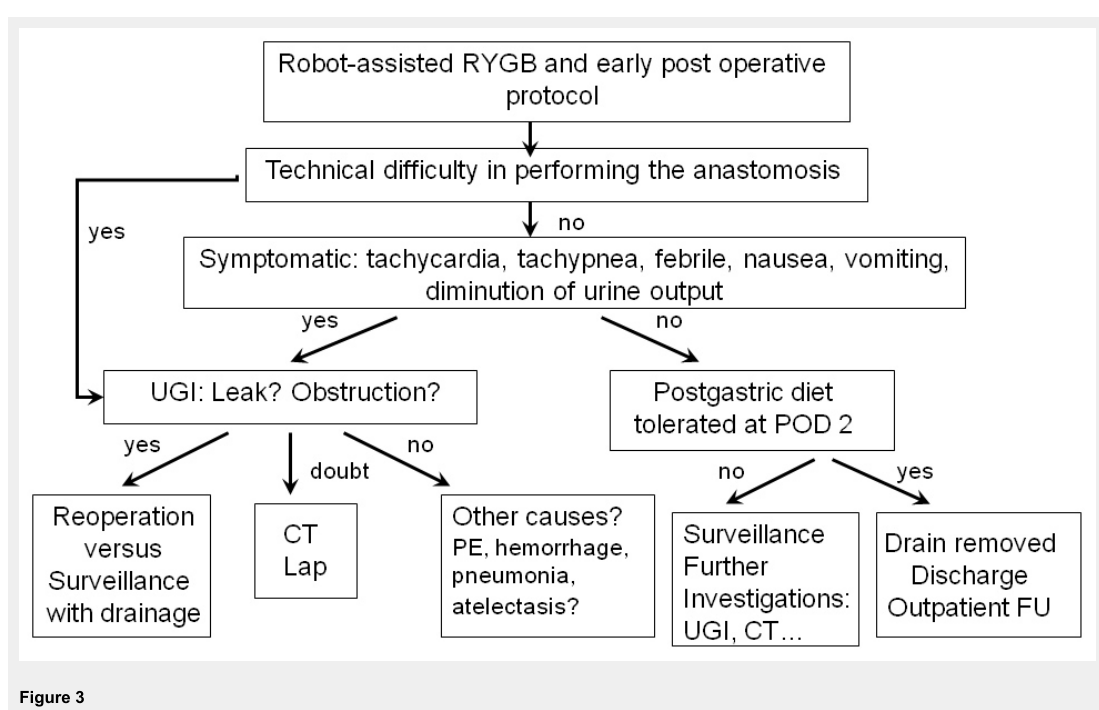
Figure 3 Decisional algorithm. FU: Follow Up. UGI: Upper Gastrointestinal series. CT: Computer Tomography. RYGB: Roux-en-Y Gastric Bypass. Lap: exploratory Laparoscopy. POD: Post-Operative Day. PE: Pulmonary